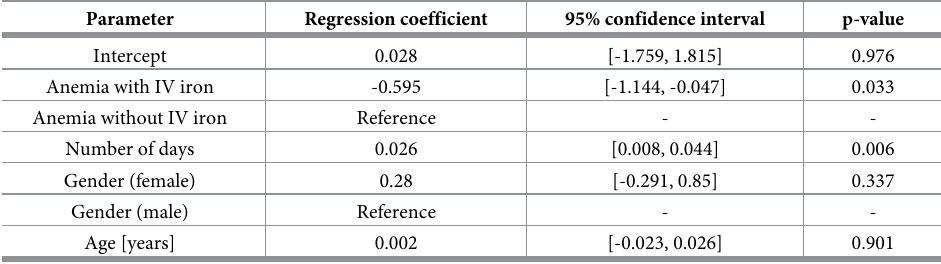
Table 1. Multivariable regression analysis for potential confounding